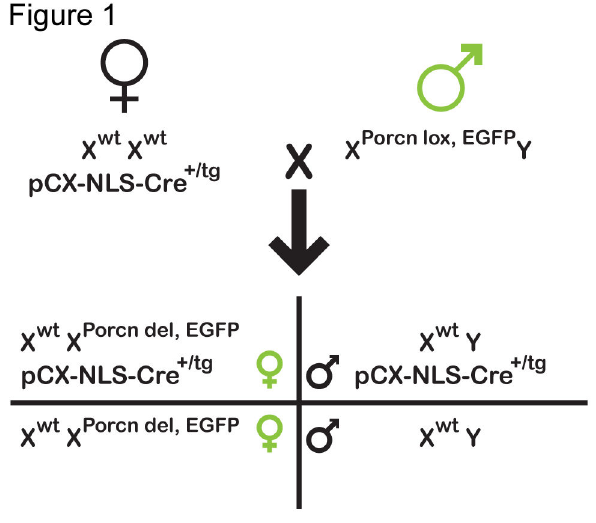
Figure 1. Schematic outline of the genetic strategy to generate Porcn +/del females. Maternally